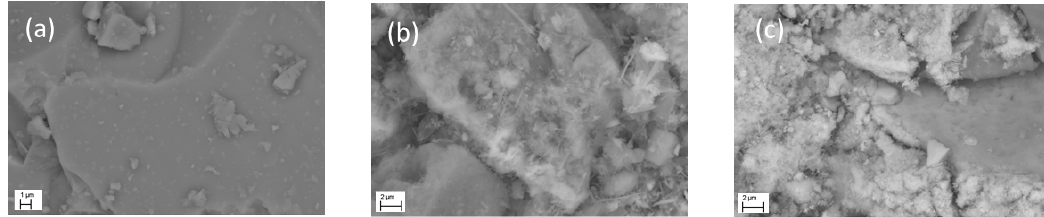
Figure 3. FESEM micrographs of BFS ( a ), Fe/BFS17.5-60 ( b ), and Fe/BFS30-60 ( c ). Dimensions in figures: 1 µm ( a ) and 2 µm ( b , c ).